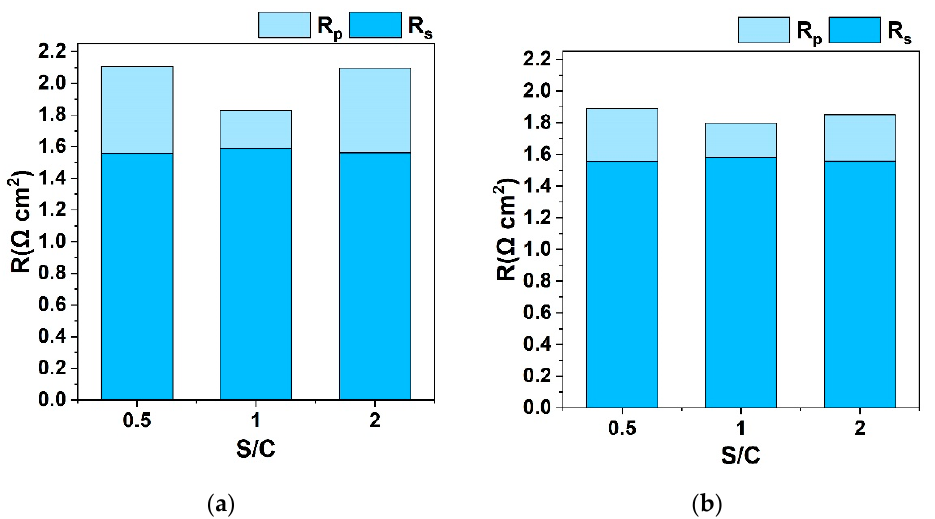
Figure 3. Ohmic (R s ) and polarization (R p ) resistance values obtained from fitting EIS data from Figure 2a,b that recorded under co-electrolysis at ( a ) 0 mA cm − 2 (open circuit) and ( b ) 250 mA cm − 2 for different H 2 O/CO 2 ratios in the fuel electrode feed with H 2 co-feed.